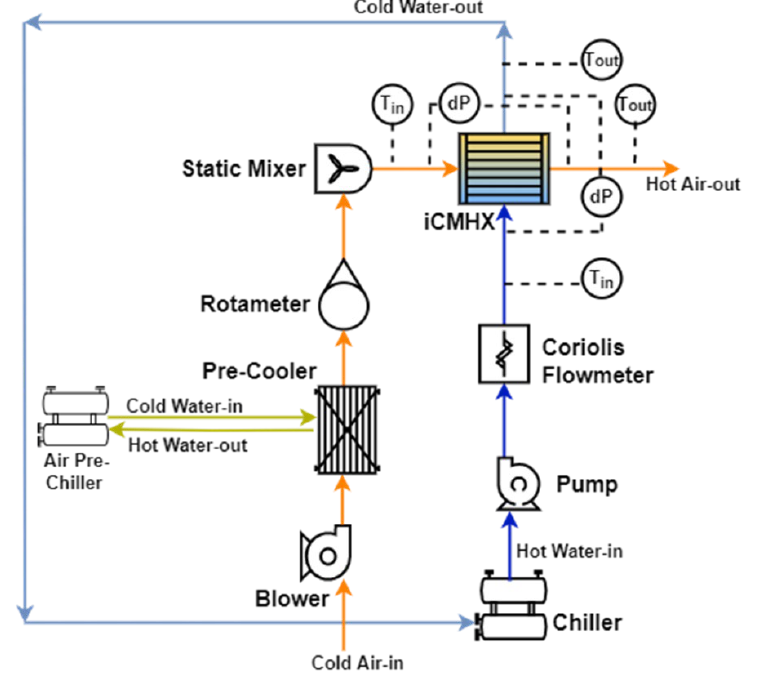
Figure 3. Schematic of the test loop.